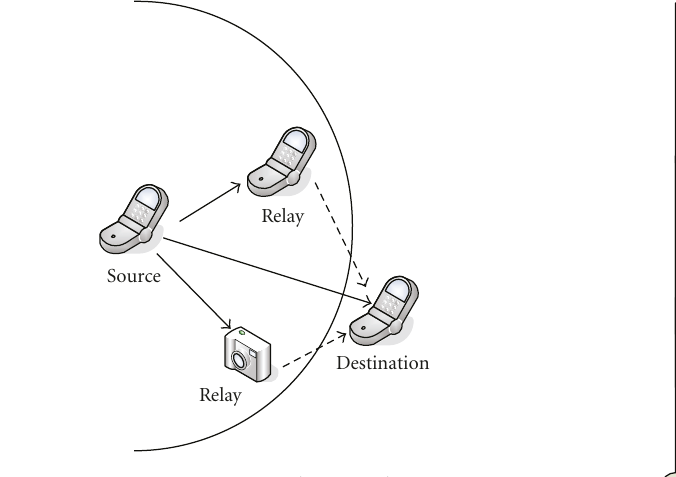
Figure 1: Cooperative scenario.